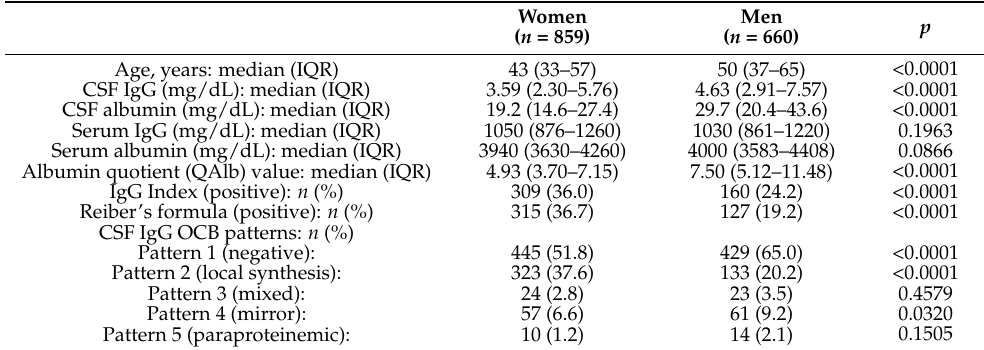
Table 1. Demographic characteristics and cerebrospinal fluid (CSF) reports of study population (cohort